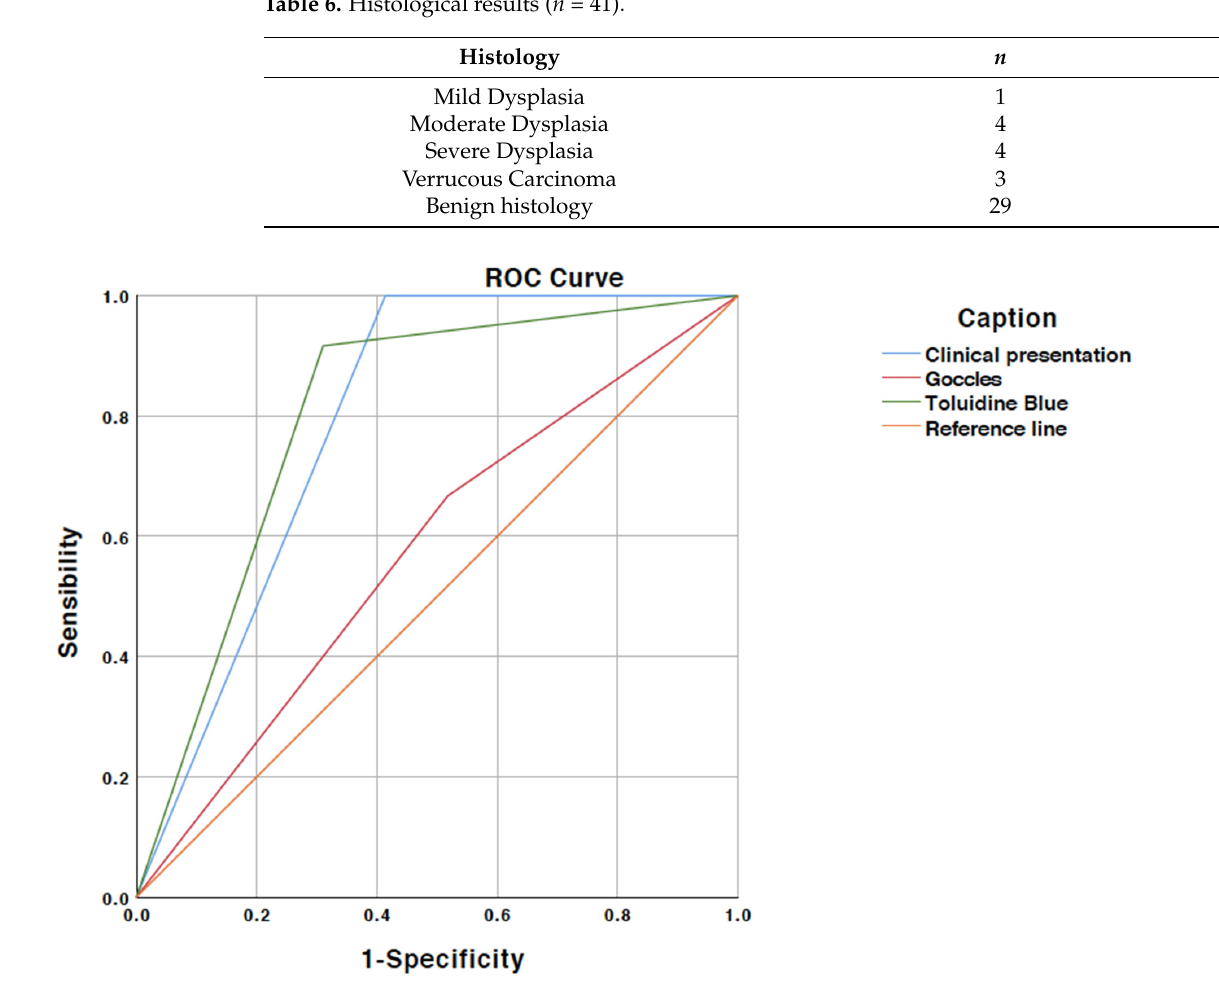
Figure 2. Roc Figure 2. Roc Curve. Table 5. Correlation of GOCCLES ® examination and Toluidine Blue staining with histopathological findings ( n = 41 lesions).